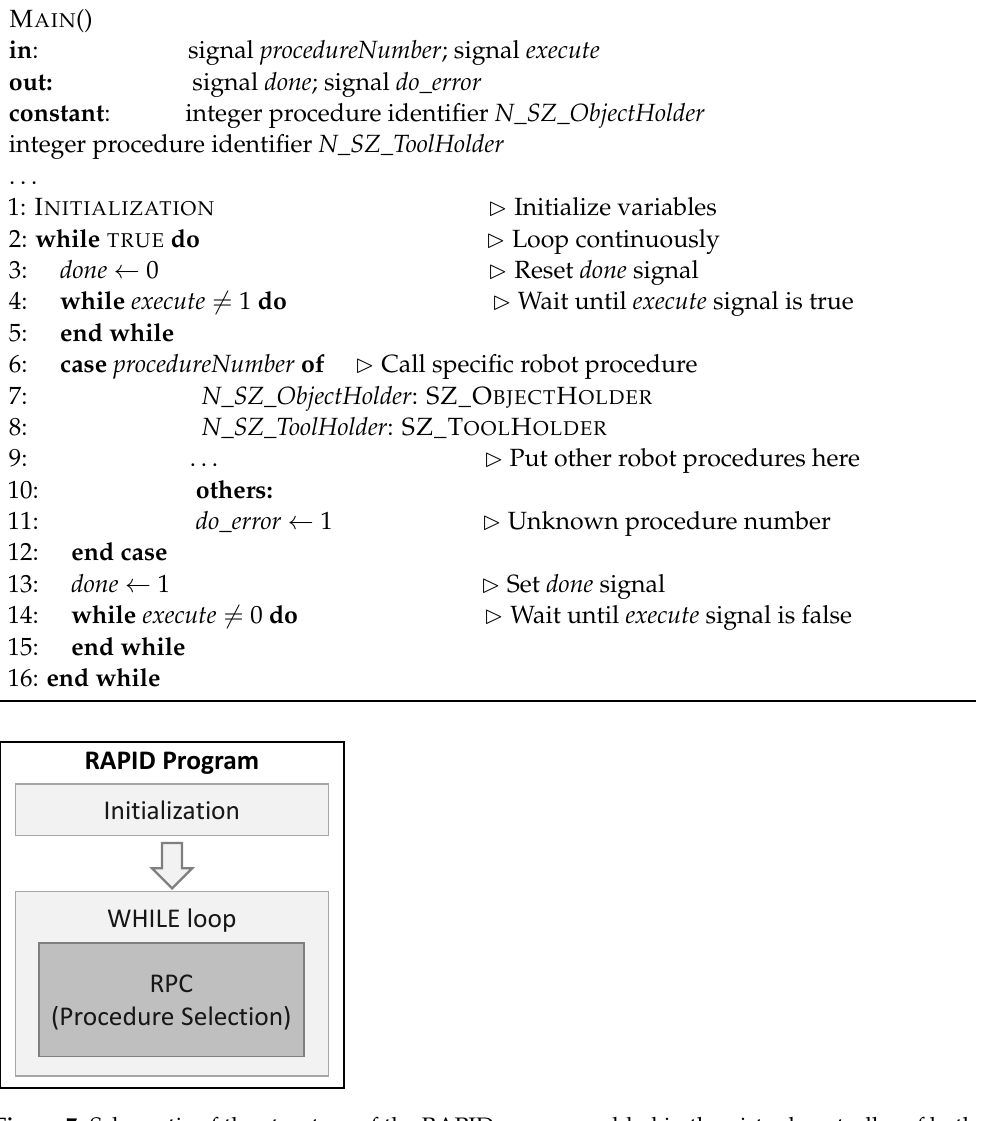
Algorithm 3 Main section with loop for RPC pattern